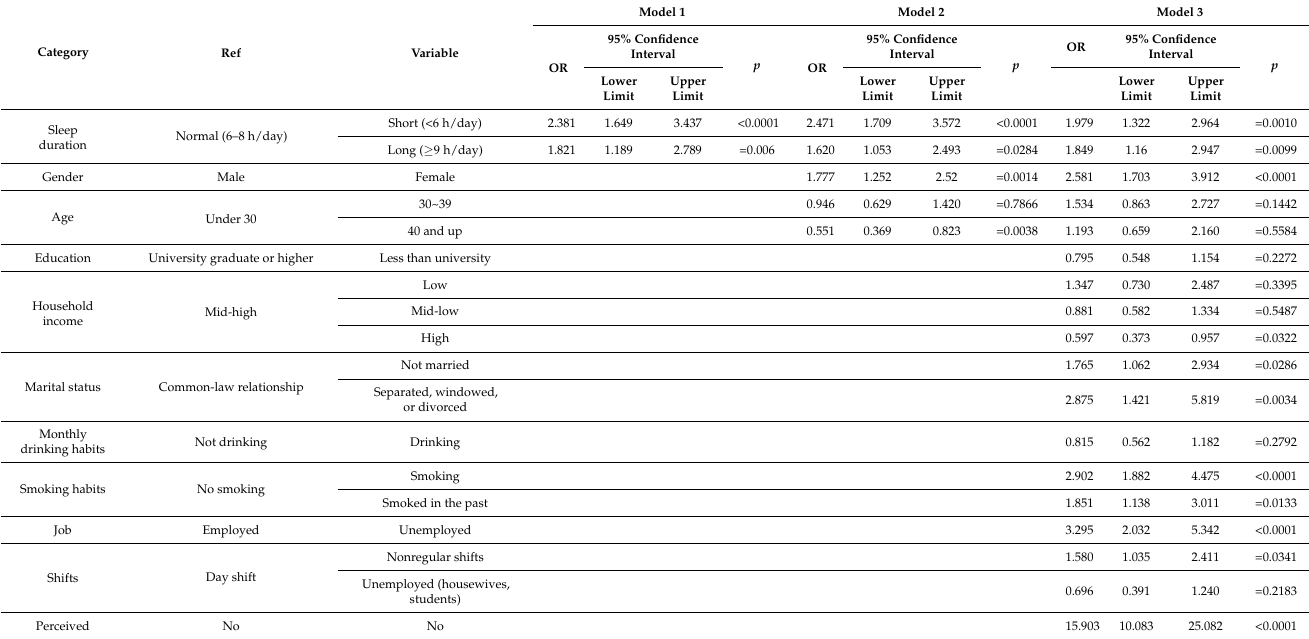
Table 3. The findings of the logistic regression analysis of the factors that affected symptoms of